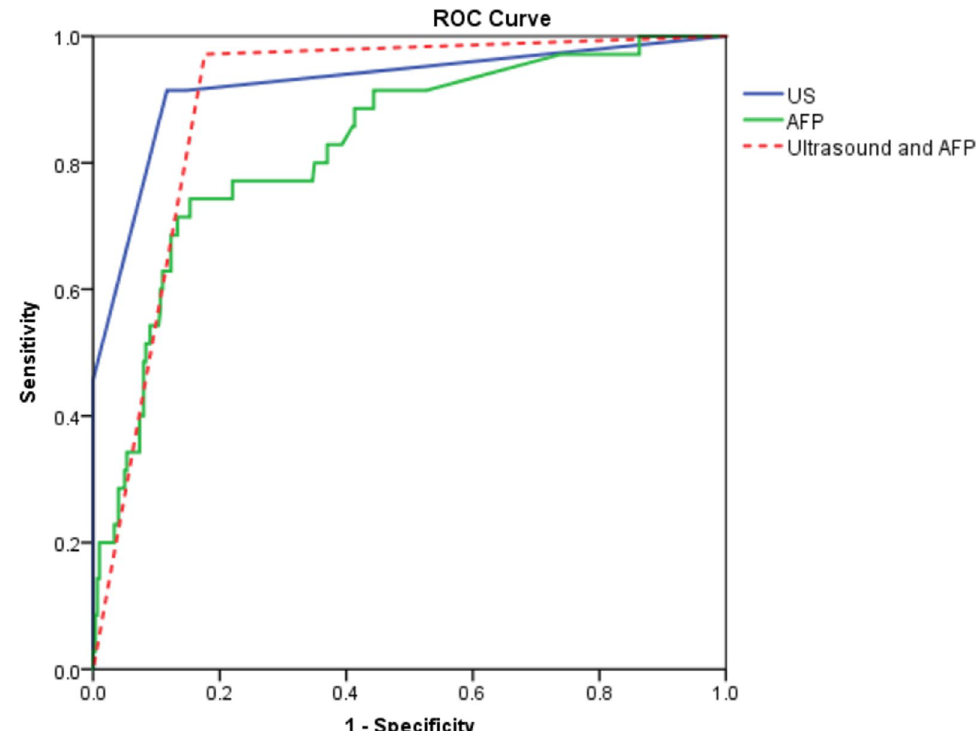
Fig. 5 ROC curve analysis for US, AFP and combined US and